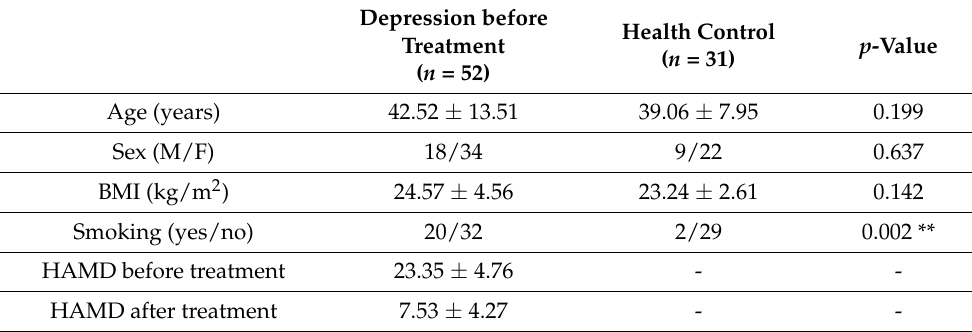
Table 2. Demographic and clinical characteristics of patients with major depressive disorder and health